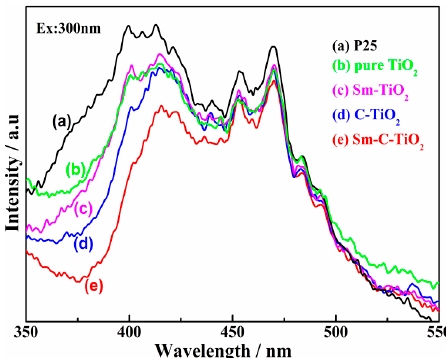
Figure 6. PL spectra of the samples. ( a ) P25; ( b ) pure TiO 2 ; ( c ) Sm-TiO 2 ; ( d ) C-TiO 2 ; ( e ) Sm-C-TiO 2 .